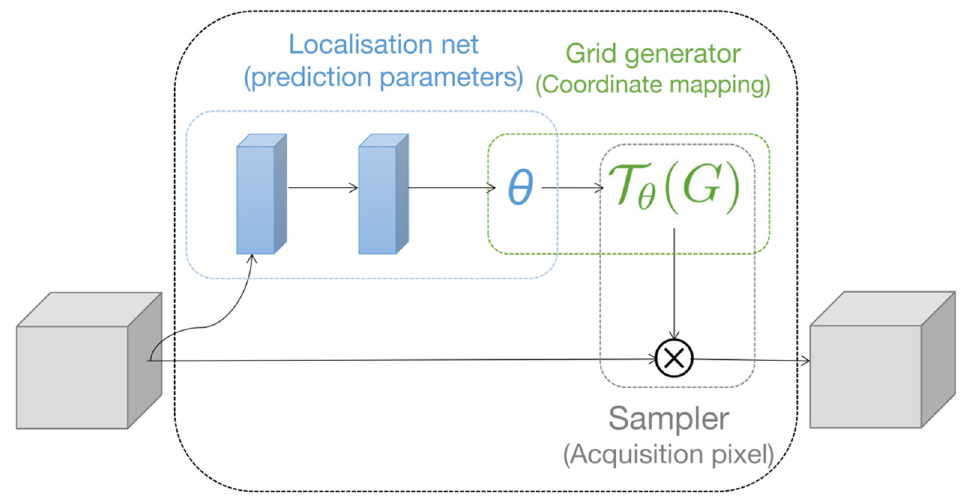
Figure 7. Spatial transformer network structure.